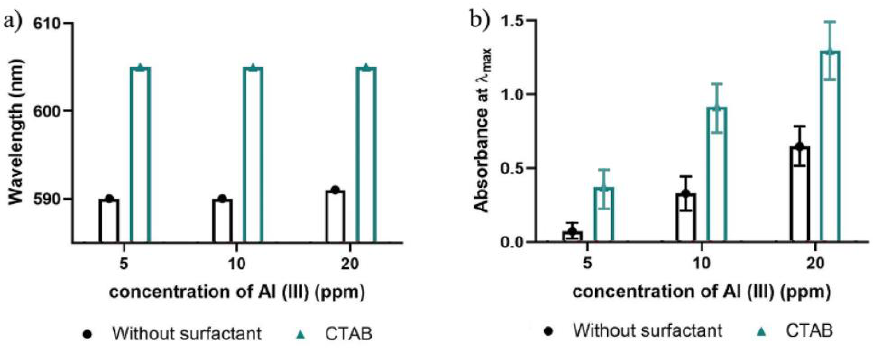
Figure 6. Effect of incorporation of 2 mL CTAB at 1 mmol L −1 into the Al(III) test solution, demon- strated by the variation in ( a ) peak wavelength and ( b ) absorbance intensity as a function of concen- tration of Al(III) solution.